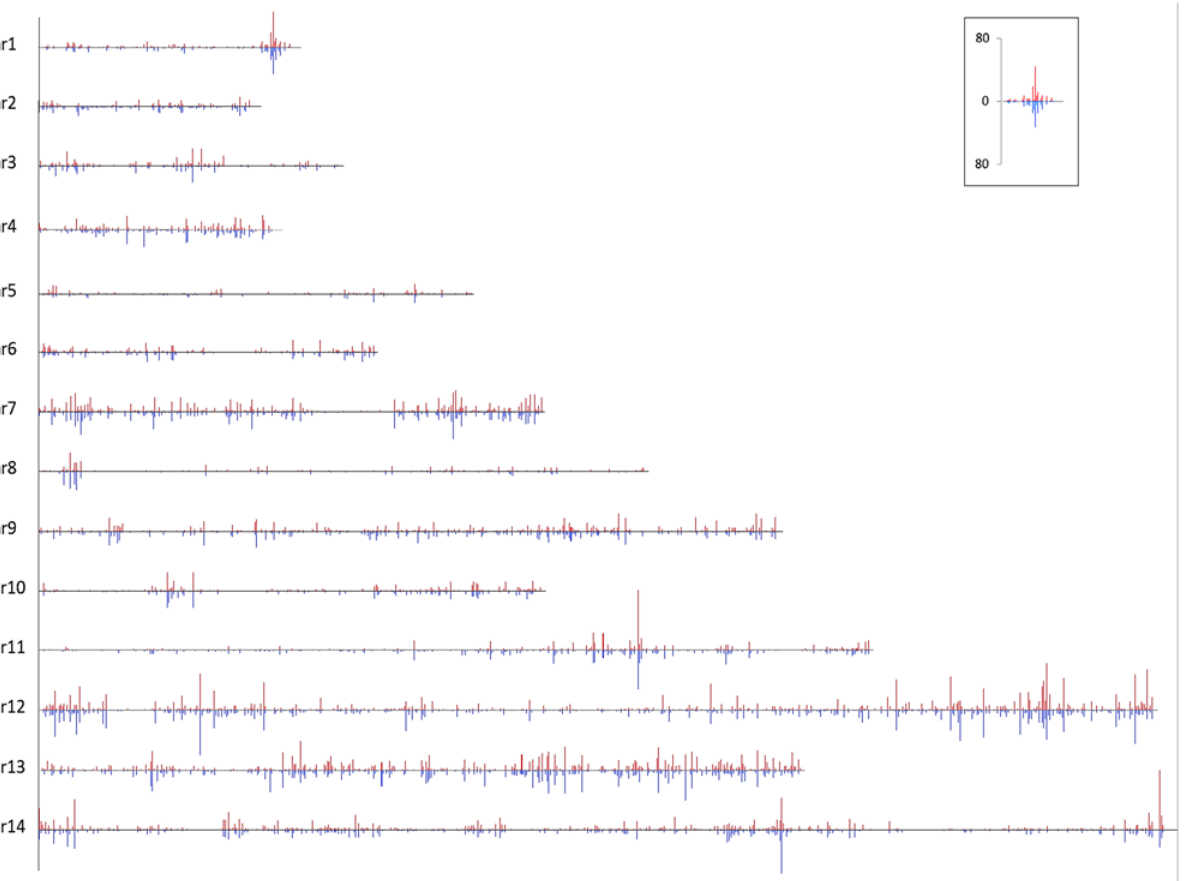
Fig 2. The number and position of SNP sites per gene co-associating with the P . knowelsi genome-wide dimorphism. Non-synonymous polymorphisms (red) are shown above the line and synonymous polymorphisms (blue) are shown below the line. The line is drawn at zero. The chromosomes are drawn to scale and the height of the bars represents the number of SNP sites per gene per region of each chromosome. The scale is given in the boxed area and is the number of SNP sites per gene.